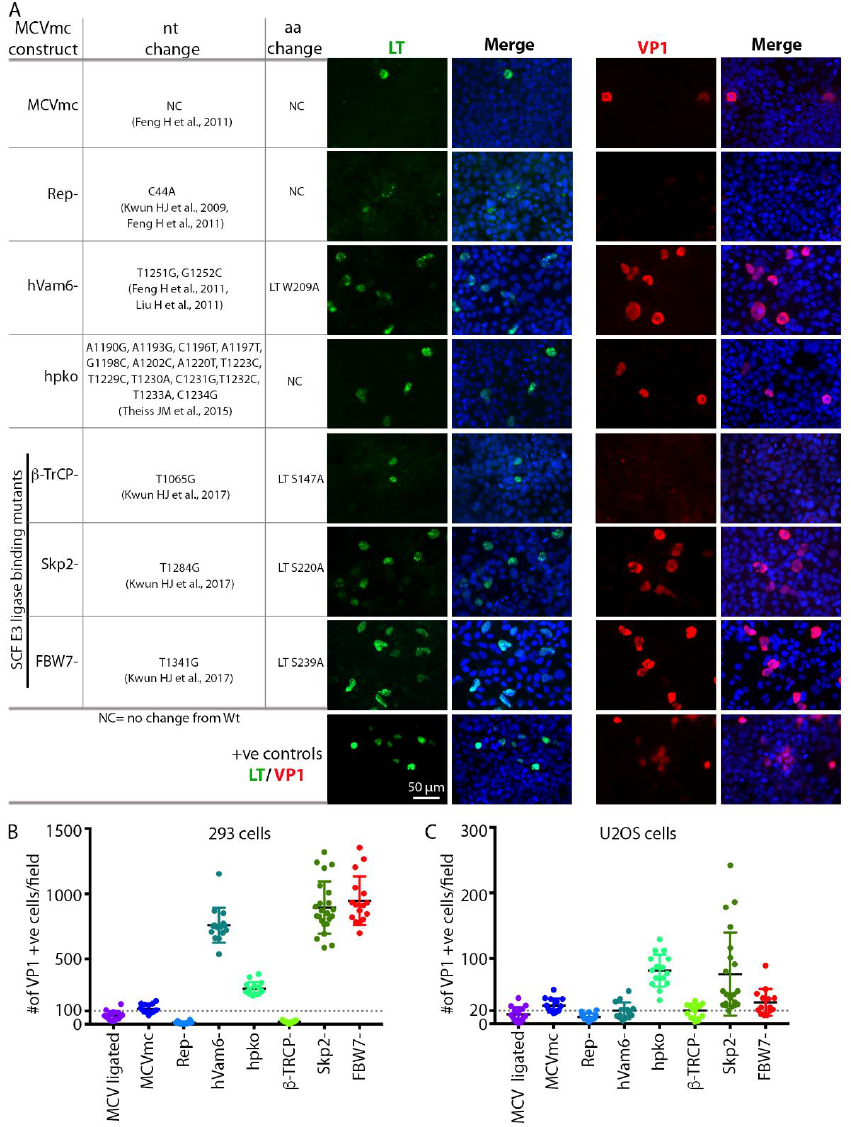
Figure 3. MCVmc is amenable to viral gene mutational analysis. ( A ) Left panel shows a table of tested MCV mutants; nucleotide (nt) and amino acid (aa) changes (based on HF strain: GenBank #JF813003) are noted for each mutant [11,12,15,23,41]. Right panel shows immunofluorescence of LT-AF488 (pseudo color green) or VP1-AF488 (pseudo color red) and DAPI (blue) in 293 cells trans- fected with MCVmc or mutants 5 days post transfection. LT or VP1-expression construct transfected 293 cells were used as positive controls. Images were originally acquired at 40× magnification. ( B , C ) Quantification of the number of VP1 positive cells per 4× magnification field in 293 or U2OS cells transfected with MCVmc or mutants 5 days post transfection. The number of VP1 positive cell was quantified using a Cytation 5 cell imaging multi-mode reader. Transfection of various mutated MCVmcs (Table 1) into either 293 or U2OS cells al- lowed both qualitative (Figures 3A and S2) and quantitative (Figure 3B, C) assessment of replication permissivity as compared to wild-type MCVmcs. LT and VP1 positive cells displayed nuclei that are 2 – 5-fold larger than uninfected cells with condensed LT nuclear